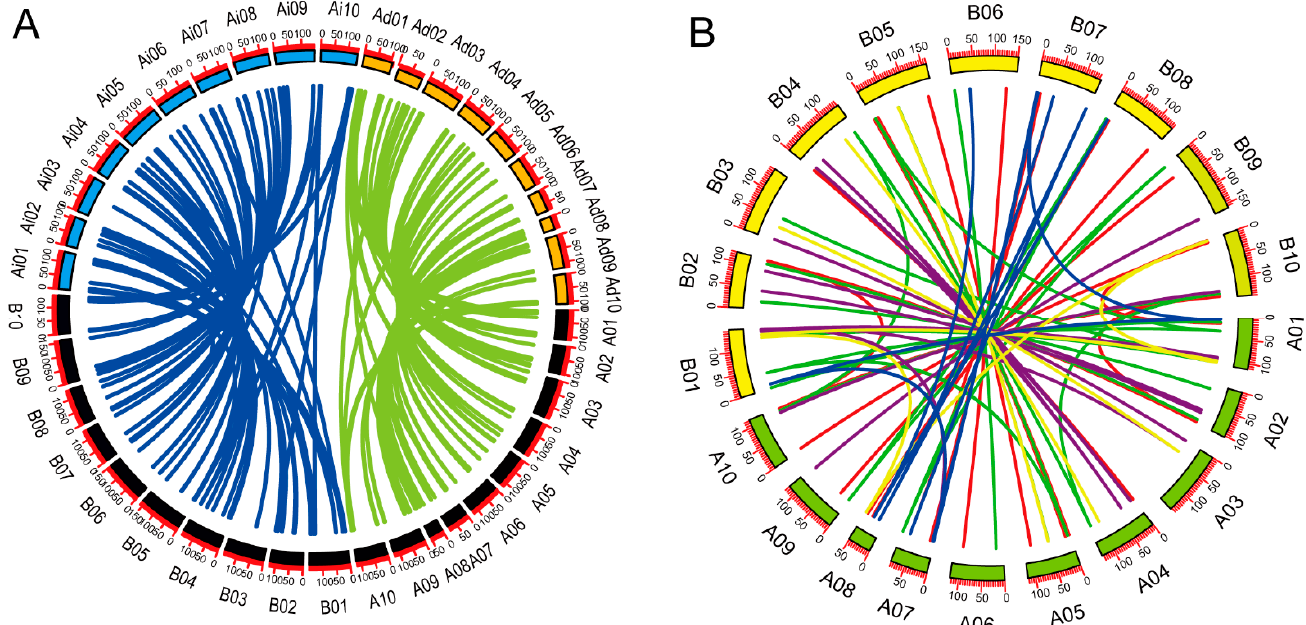
Figure 5. Collinearity analysis of SNARE genes. ( A ) Synteny analysis of SNARE genes in A. hypogaea – A. duranensis and A. hypogaea – A. ipaensis . Green lines indicate syntenic genes between A. duranensis and A. hypogaea . Blue lines indicate syntenic genes between A. duranensis and A. hypogaea . Black boxes represent A. hypogaea chromosomes. Colored boxes represent chromosomes of A. duranensis and A. ipaensis . Ad, A. duranensis ; Ai, A. ipaensis ; Ah, A. hypogaea . ( B ) Synteny analysis of SNARE genes within A. hypogaea . Colored lines represent syntenic relationships between different type of SNAREs. Red, Qa-SNARE; green, Qb-SNARE; blue, Qb+c-SNARE; purple, R-SNARE. Scale bar represents megabases (Mb). Chromosome numbers are indicated on the top of each bar. Green boxes represent A genome; yellow boxes represent B genome.